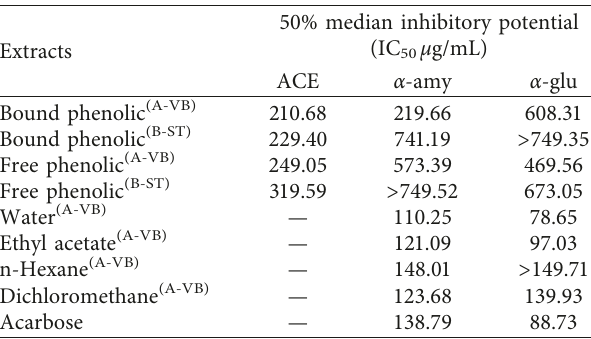
Table 2: Inhibitory potential of medicinal plants A-VB and B-ST.